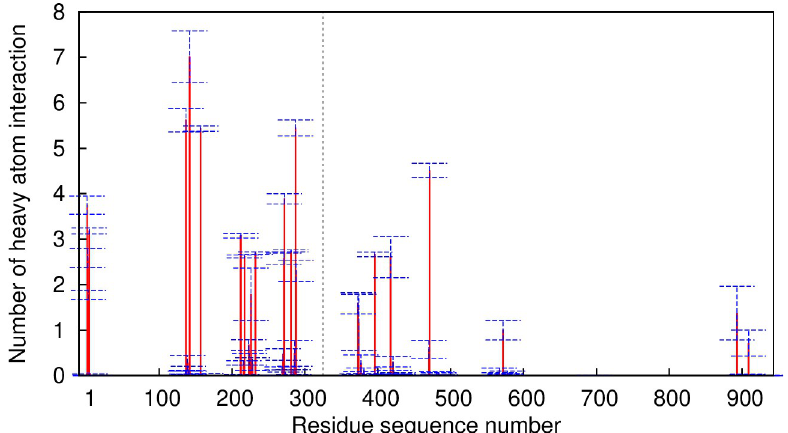
Fig 8. The numbers of contacts between heavy atoms of PIP 2 and PLD2 residues within 3.5 Å . Data were obtained from the last 1 μ s trajectories of the replica R1 of the 10% system, dividing into 5 blocks of 200ns to estimate the average and standard error (SE). The vertical dotted line indicates the border between N-term and C-term. https://doi.org/10.1371/journal.pone.0236201.g008 Table 2. PIP 2 binding residues. Ranking Residue b